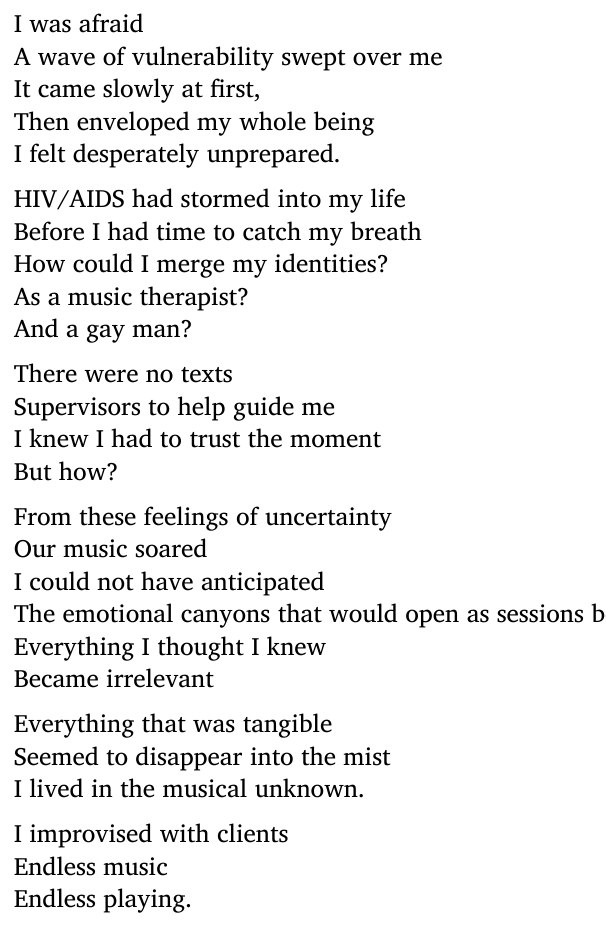
figure: Recording Session, Maureen Forrester Hall). These sessions comprised of semi- composed and composed pieces, as well as free improvisations. The focus of the mu- sic was to reflect on my work as a queer therapist – a personal exploration through an artistic, non-verbal perspective. The five pieces included in this article came from the final recording session. During this time, I improvised without pre-conceived musi- cal ideas. I considered my experiences with clients both individually and collectively. These recordings were genuine expressions that sounded my authentic self. Not only clear representations of my sexuality and passion for music, but also expressions that articulated other intersecting aspects of my identity – my gender, race, ability, vul- nerabilities and privileges in life. Music by its sheer force can speak to that which is human in